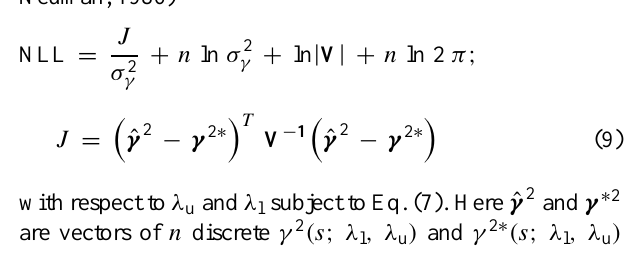
Fig. 12. ξ(q) versus q evaluated for r i =1.27cm using all the avail- able data in x and y directions. ESS estimates obtained in x direction on face 1 are included for